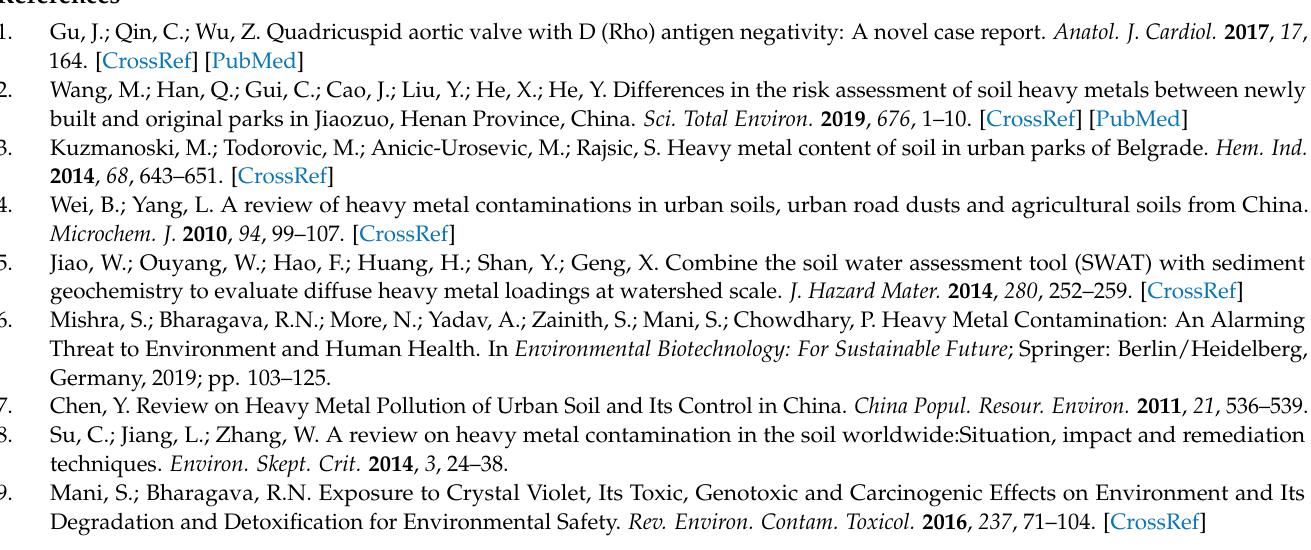
Table S5: The related parameters used in the Monte Carlo simulation; Table S6: Statistical summary of heavy metal(loid) concentrations (mg · kg − 1) in surface soils of this study and global urban parks given in literature; Table S7: Summary statistics for non-carcinogenic and carcinogenic health risk range based on Monte Carlo simulation using Crystal Ball (vs. 11.1.2.4). References [63–79] are cited in the supplementary